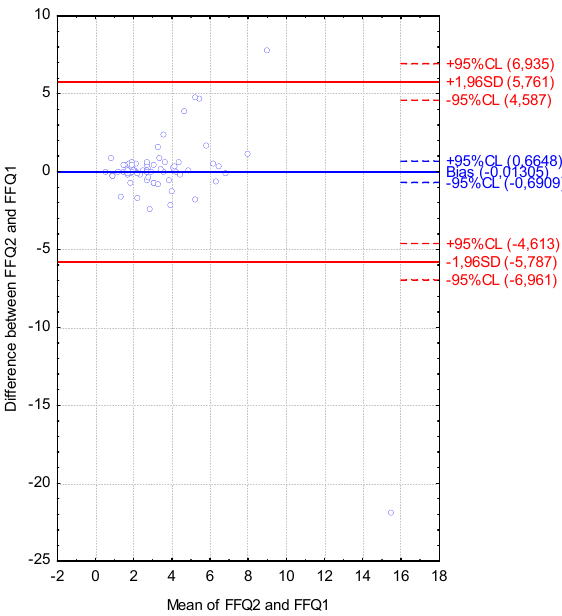
Figure 6. Bland ‐ Altman plot comparing VIDEO ‐ FFQ2 with VIDEO ‐ FFQ1 of Vitamin D daily intake Figure 6. Bland-Altman plot comparing VIDEO-FFQ2 with VIDEO-FFQ1 of Vitamin D daily intake (Bland ‐ Altman index of 2.7%). FFQ1—VIDEO ‐ FFQ filled out immediately after conducting the three ‐ (Bland-Altman index of 2.7%). FFQ1—VIDEO-FFQ filled out immediately after conducting the day dietary record; FFQ2—VIDEO ‐ FFQ filled out six weeks after FFQ1. three-day dietary record; FFQ2—VIDEO-FFQ filled out six weeks after